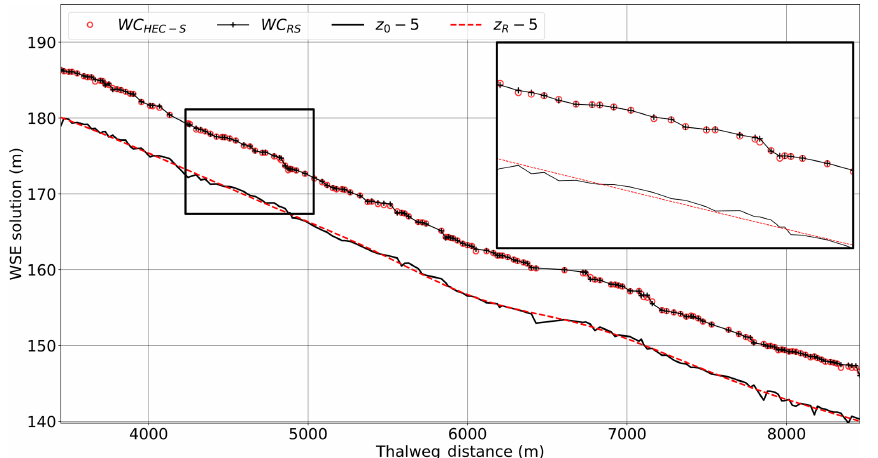
Figure 18. Comparison of SPRNT-RS to steady HEC-RAS for water surface elevations in Waller Creek simulations with expanded detail to show similarities. For clarity, 5m is subtracted from the channel z